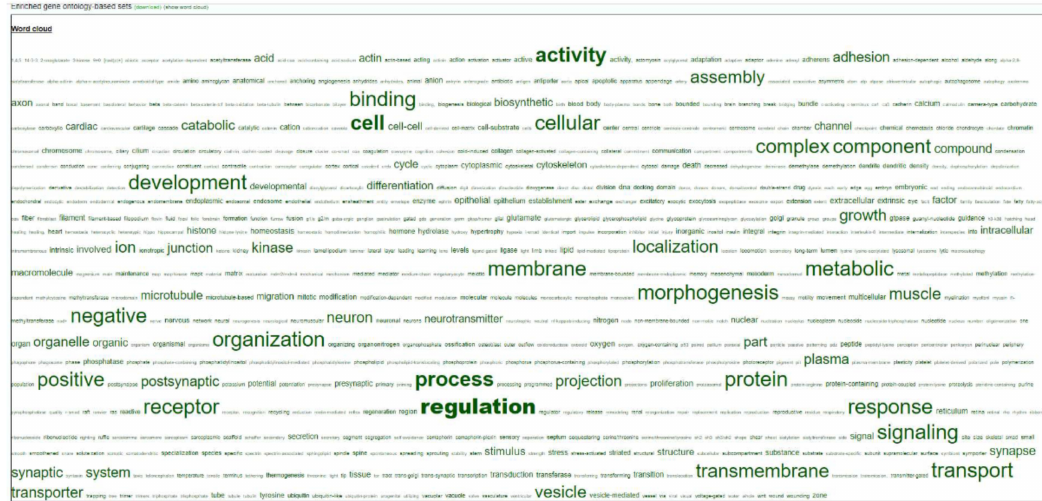
Figure 8. Word cloud for enriched gene ontology-base sets in female vs. male INVIVO